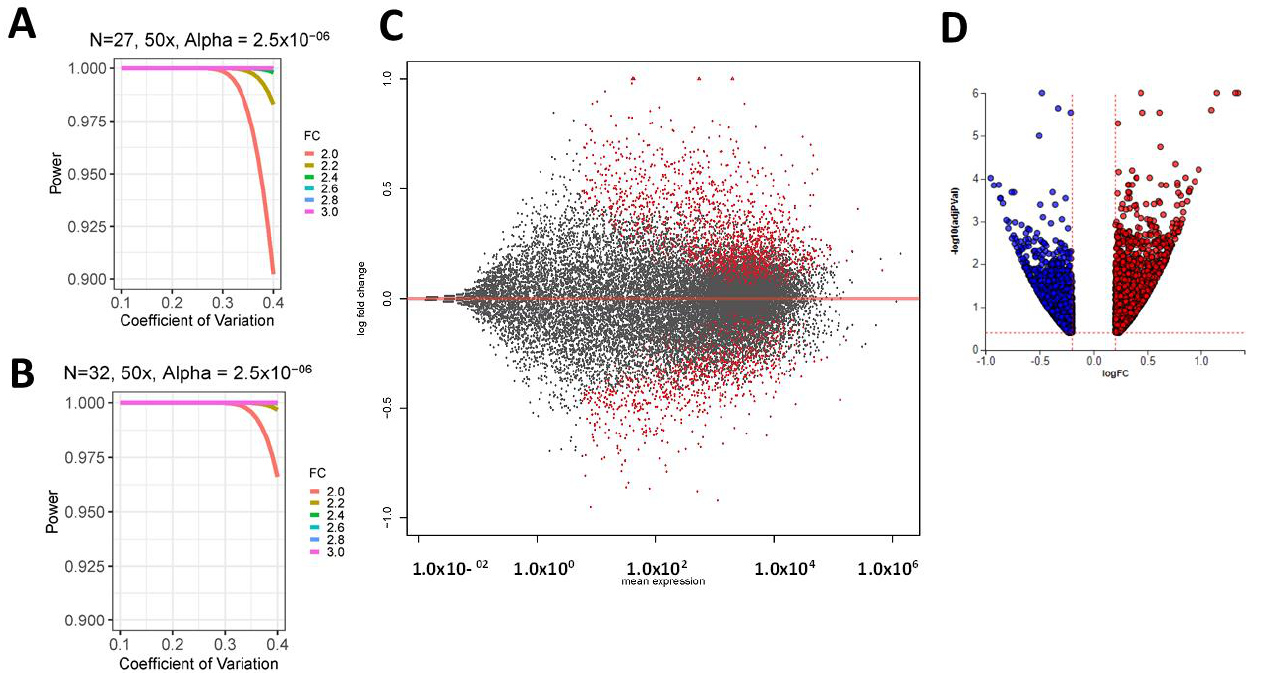
Figure 1. Power analysis plots with power as a function of the co-efficient of variation (CV), using ( A ): 27 and ( B ): 32 replicates respectively to detect FC values ranging from 2.0 to 3.0. Type I error rate is conservatively fixed at α = 2.5 × 10 −6 ( α = 0.05 after Bonferroni Correction). ( C ) MA Plot examining differential gene expression between EA and AA men. The plot visualizes the differences between measurements taken in two samples, by transforming the data onto M (log ratio) and A (mean average) scale. M (Y-axis) is plots differential gene expression (log2 (EA /AA). A (X-axis) plots transcript abundance (0.5 log2 AA + 0.5 log2 EA). significant transcripts ( q < 0.1) are highlighted in red. ( D ) Volcano plot depicting the DE genes in the contrast between AA and EA men. The horizontal axis is the log fold change, and the vertical axis is the negative base-10 logarithm of the adj p -value or q -value. The red-dotted lines represent the threshold. The up-regulated genes (positive log fold change) are shown in red, while the down-regulated genes are blue. AA: African – American; EA: European – American.